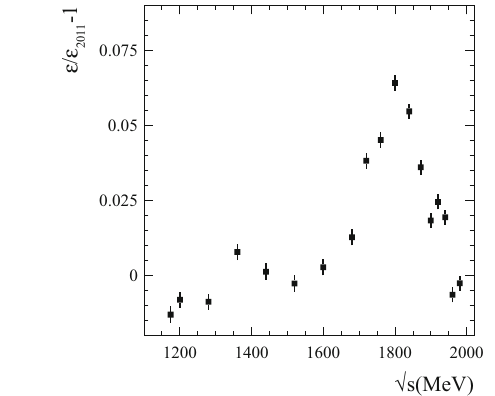
Fig. 3 The relative difference between the detection efficiency for e + e − → π + π − π 0 events calculated in this work ( ε ) and the efficiency calculated in Ref. [5] ( ε 2011 ) using the model from Ref. [21]